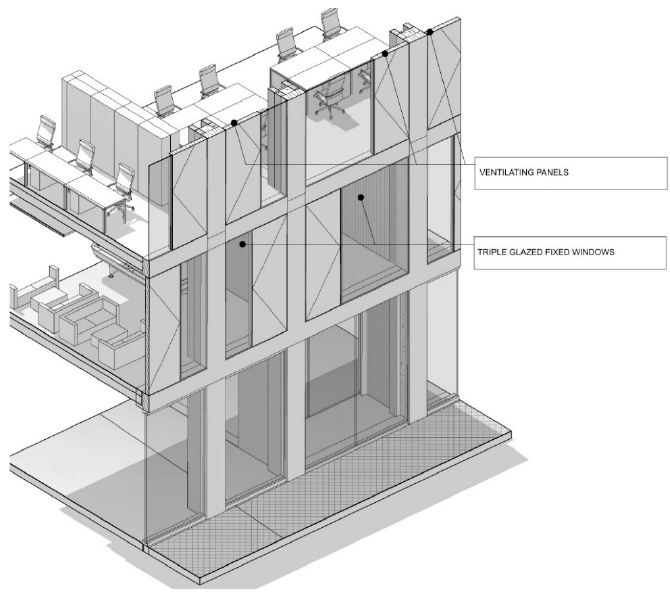
Figure 8. A 3D cross section through the aerating elevation proposed for north and east exposures.